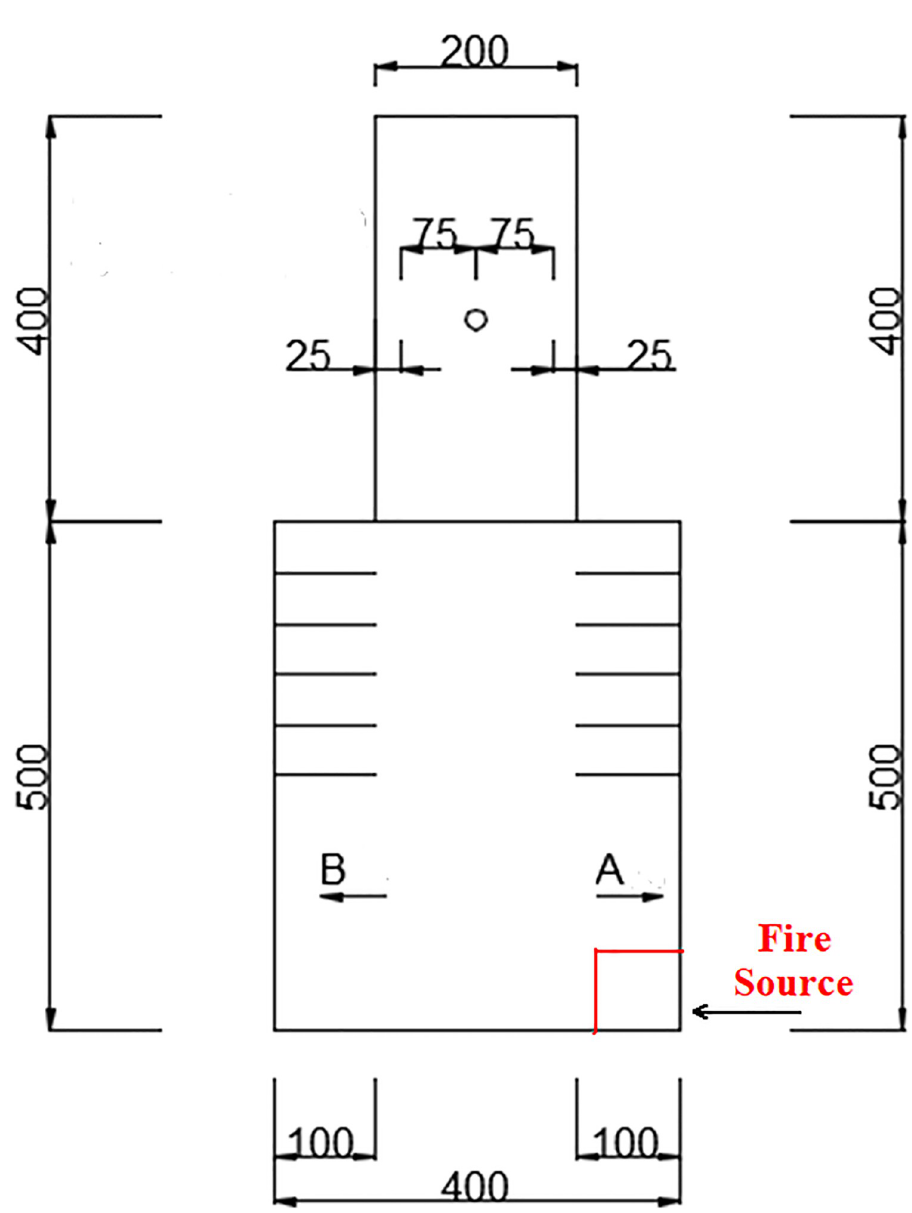
Fig 3. The schematic layout of fire source location of experimental